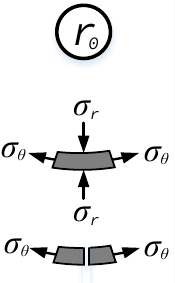
Figure 9. Schematic diagram of tensile failure of rock under stress wave action.